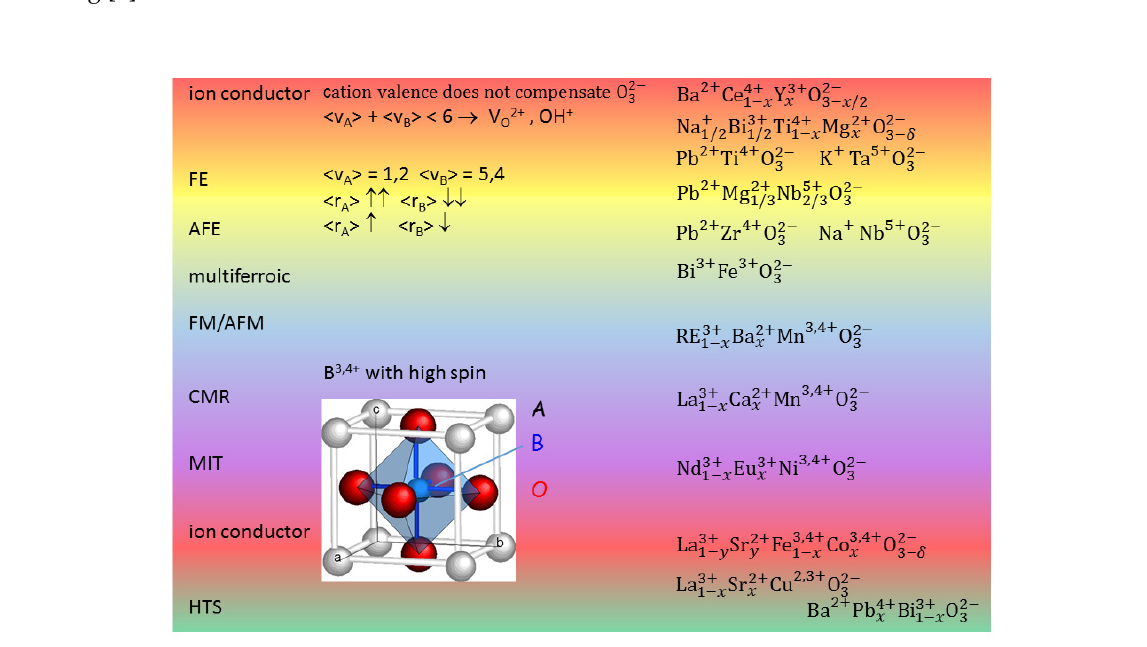
Figure 1. The cubic perovskite structure and some types of perovskites exhibiting different properties; v indicates the valence and r is the ionic